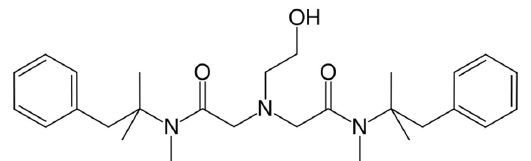
Figure 1. Chemical structure of Oxethazaine drug, (2,2’-(2-Hydroxyethylimino)bis[N-(alphaalpha-dimethyl phenethyl)-